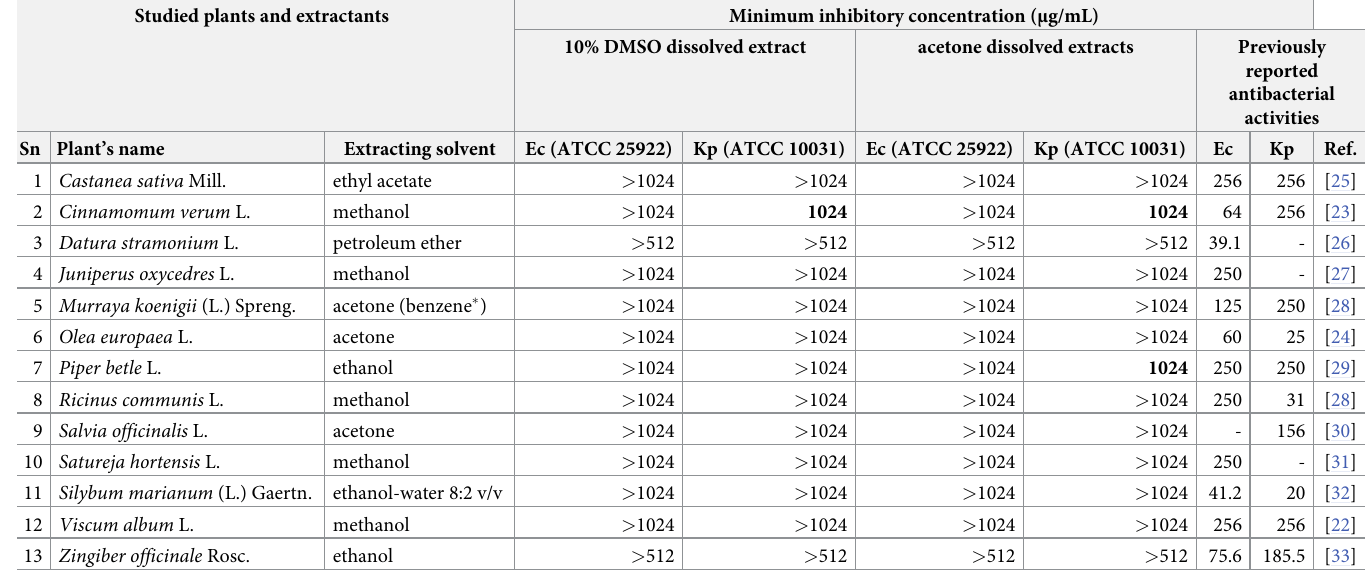
Table 2. Minimum inhibitory concentrations (MICs) of 10% DMSO and acetone dissolved extracts of plant species identical to those reported in the literature. Studied plants and extractants